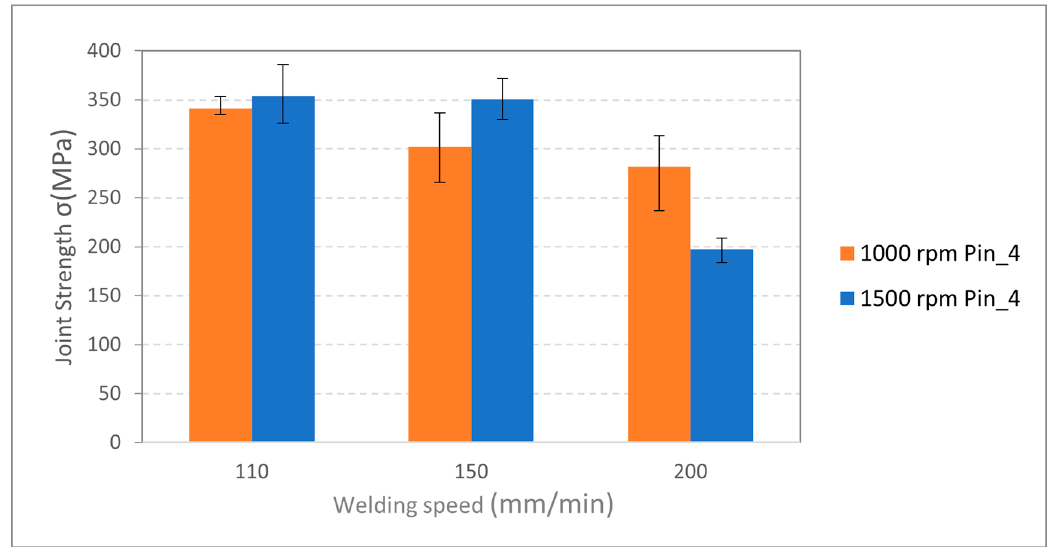
Figure 11. Comparison of tensile strength for joints for different welding speeds for 4 mm diameter pin tool.